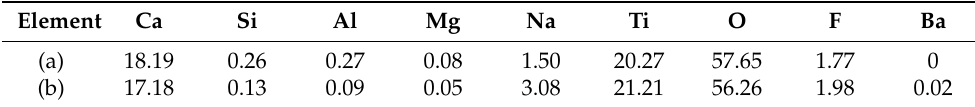
Figure 7. SEM microphotograph image of the intermediate reaction layer between the mold flux (2#) and rod: ( a ) TiO 2 ; ( b ) TiN. Table 4. EDS analysis of absorbing Ti inclusions by mold flux (2#).